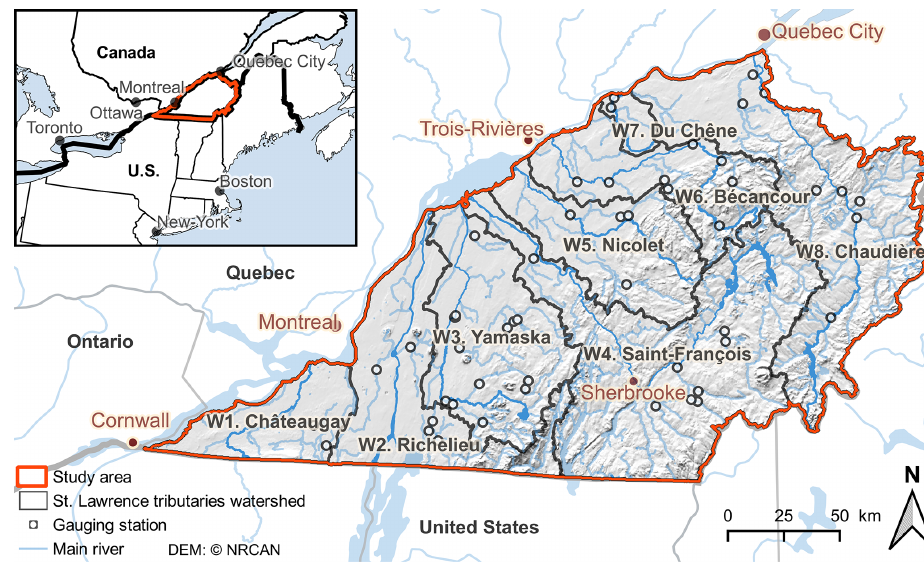
Figure 1. Location of the study area and watersheds. Table 1. Characteristics of the studied watersheds. Elevation Area Land cover Temp. Precip. (ma.s.l.) Max Agriculture Forest Wetland Urban